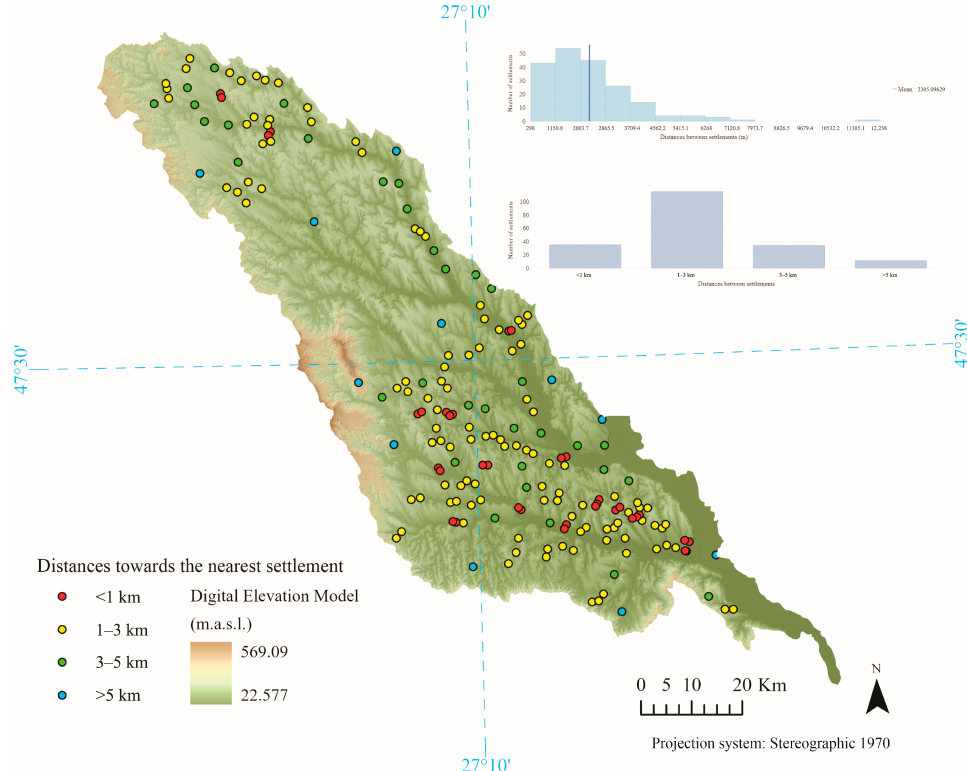
Figure 10. Noua settlements with ashmounds classified according to the distance towards the nearest similar settlement, with graphs showing the values obtained for all the sites and their distribution within the main categories.